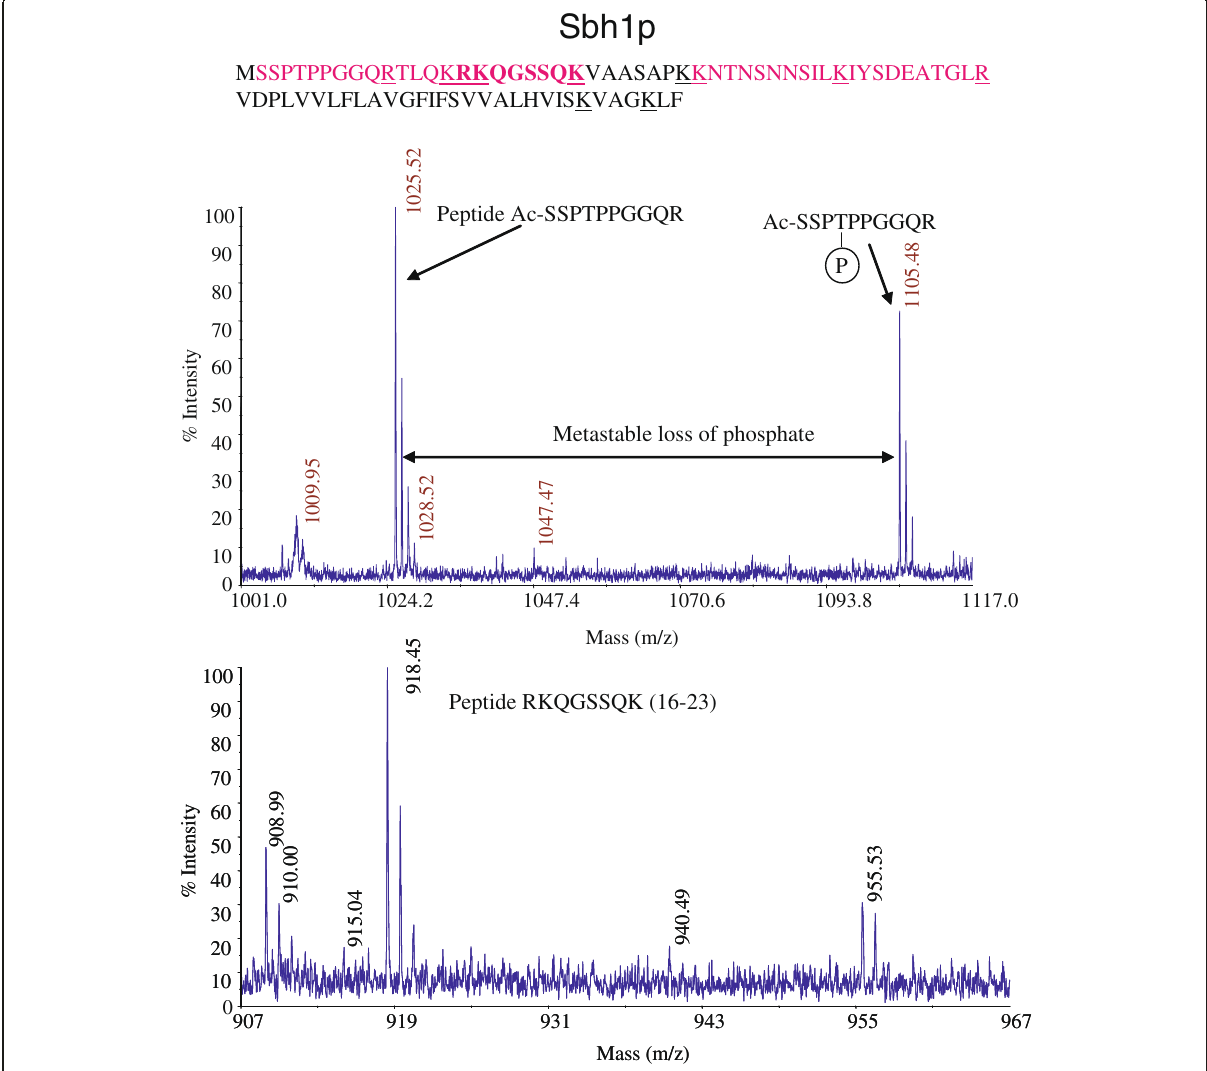
Figure 3 Identification of a phosphorylated site in Sbh1p by mass spectrometry. Sec complex was purified using membranes from an SSS1-HA tagged strain as in Methods. The Sbh1p band was excised, digested with trypsin, and the resulting peptides analyzed by mass spectrometry. The amino acid sequence of Sbh1p is shown. Peptides covered in the analysis are shown in pink. Trypsin cleavage sites are underlined. Peaks corresponding to the phosphorylated peptide are indicated. Note that S27 is the only potential phosphate acceptor site in the Sbh1p cytosolic domain not covered by this